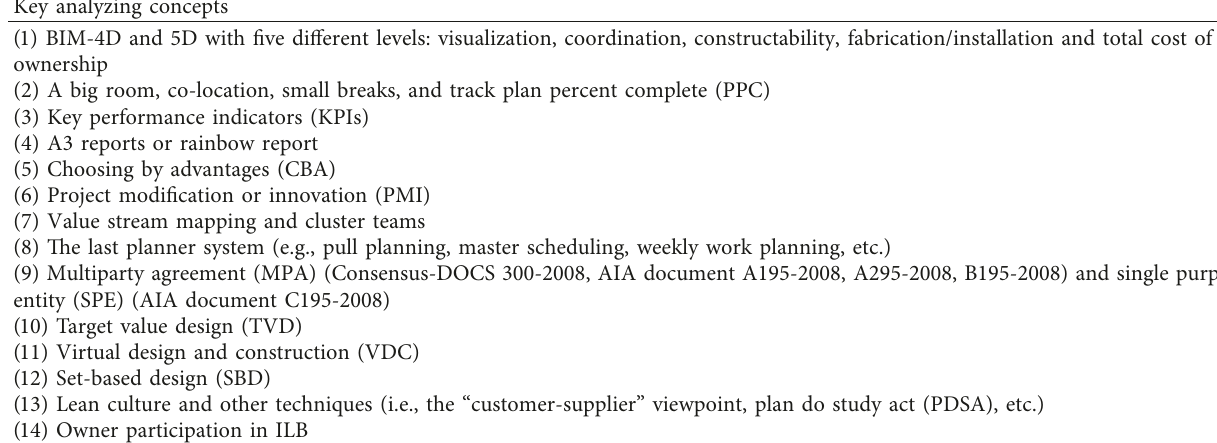
Table 3: Synergizing concepts from case